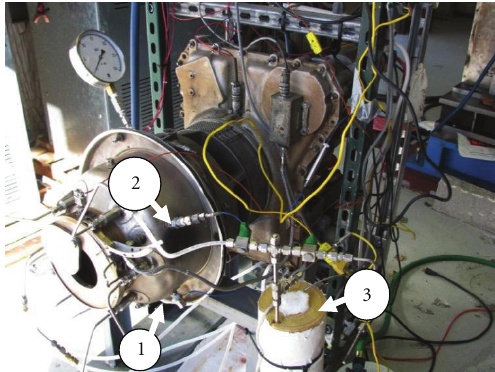
Figure 11: Gas turbine used for experimental studies; (1) vibration sensor, (2) pulsation sensor, and (3) water